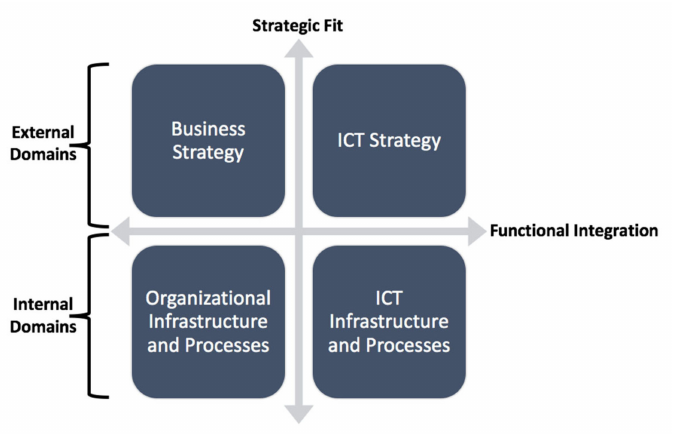
Figure 1. The strategic alignment model concept